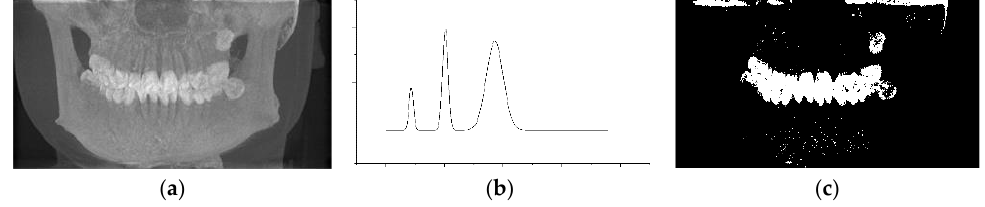
Figure 3. The axial slice range detection process. ( a ) Coronal MIP images. ( b ) Hu histogram of coronal MIP. ( c ) Dental mask image.